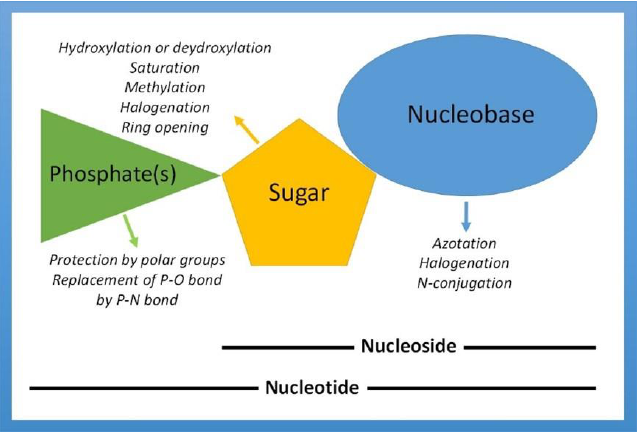
Figure 1. Schematic representation indicating the most common chemical modifications of nucle- obases, nucleosides, and nucleotides suitable to give pharmacologically active antitumor and/or antiviral analogues. Adapted from [2], published by Nature Publishing Group, 2013. Despite chemical changes, showing a structure very similar to that of endogenous nucleos(t)ides, the NAs can maintain the ability to enter cells by exploiting specific plasma membrane nucleoside transporters [34,35]. Organic cation and/or anion transporters, not specific for nucleosides, can also be involved in the cellular uptake of some NAs [2]. These classes of antitumor and/or antiviral compounds can differ for the types of transporters used and for their preferential interaction with specific targets. This can explain the effec- tiveness differences observed for these compounds in the treatment of neoplasia with pro- tracted evolution, rapidly proliferating tumors, and viral diseases [36]. A major difference of the NAs used as antiviral drugs, with respect to those used as antitumor agents, consists